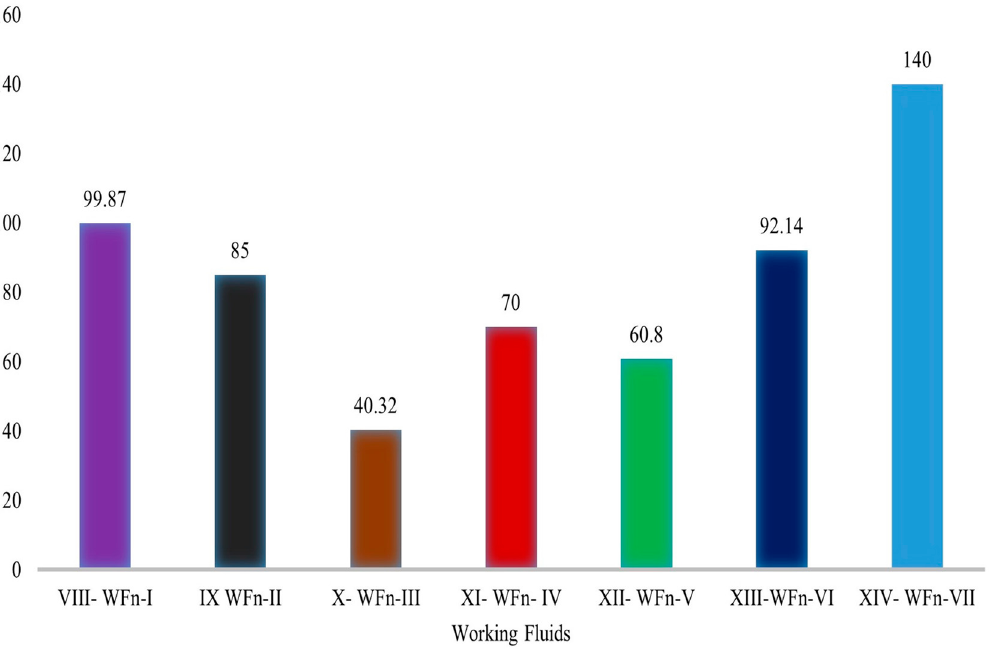
Figure 11. Illustration on the obtained NPV of the con fi gurations placing working fl uid in multiple modes. Table 7. Results comparison of the present study and reference